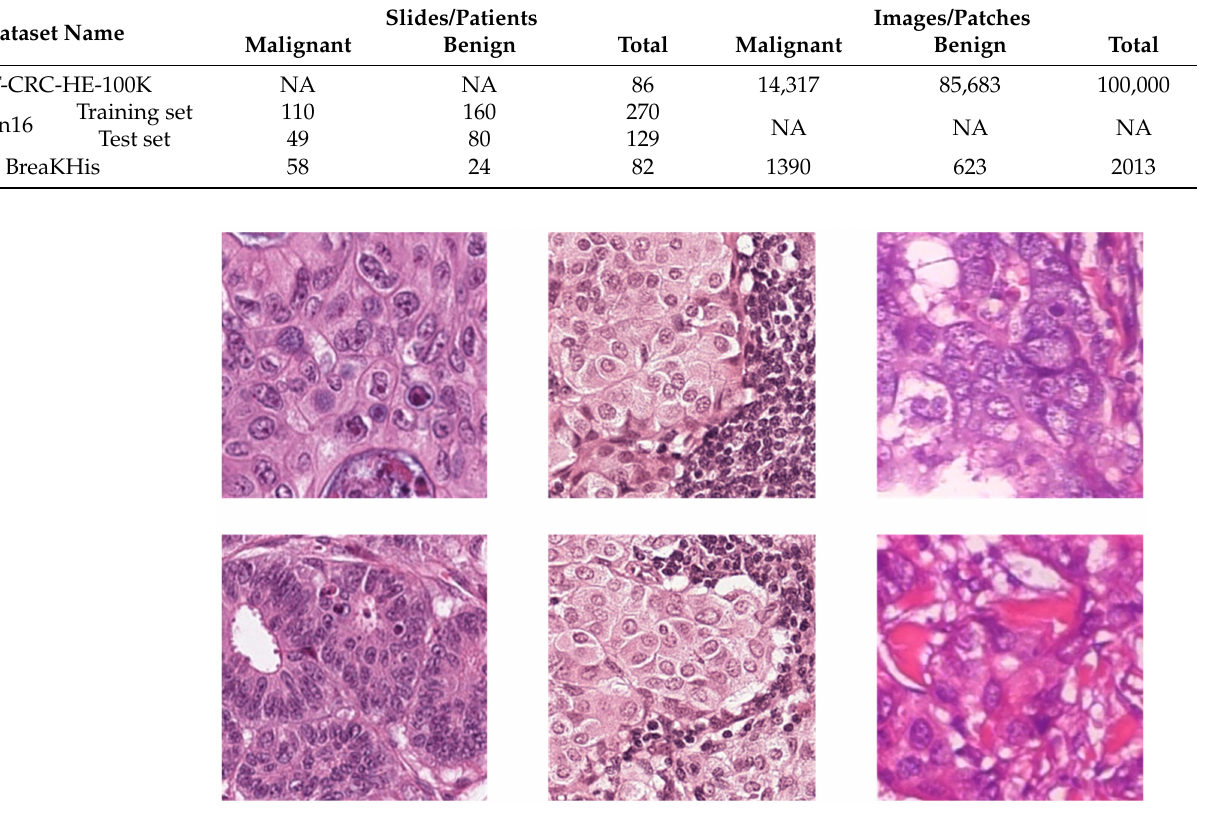
Figure 1. The sample images of three datasets. The columns from left to right are CRC, sentinel lymph node metastasis and breast